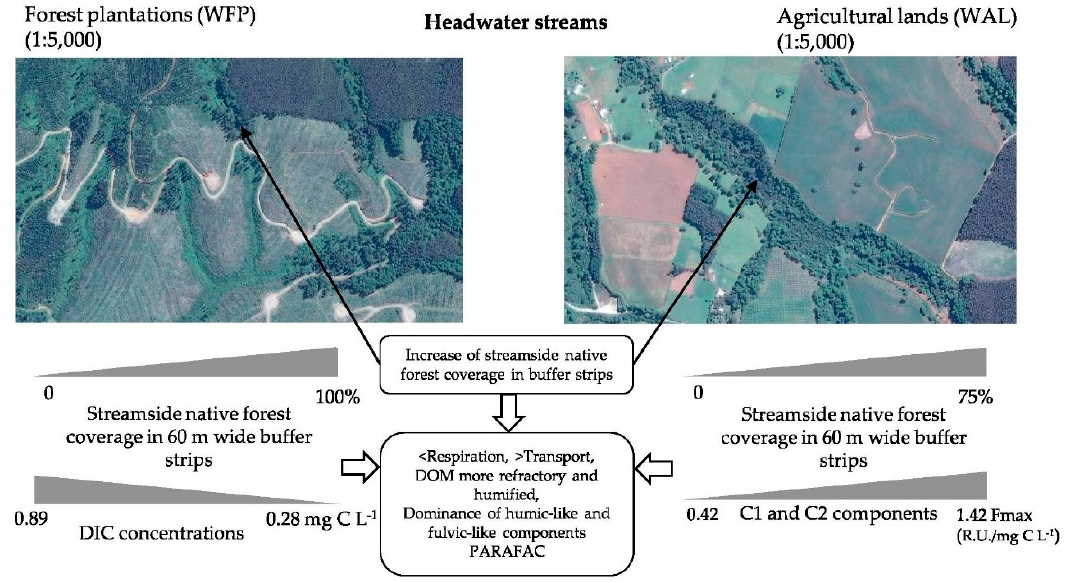
Figure 5. Conceptual model of the role of native forests in buffer strips and variations of the characteristics of Dissolved Organic Matter (DOM) in headwater streams dominated by forest plantations and agricultural lands with an increase in streamside native forest coverage.